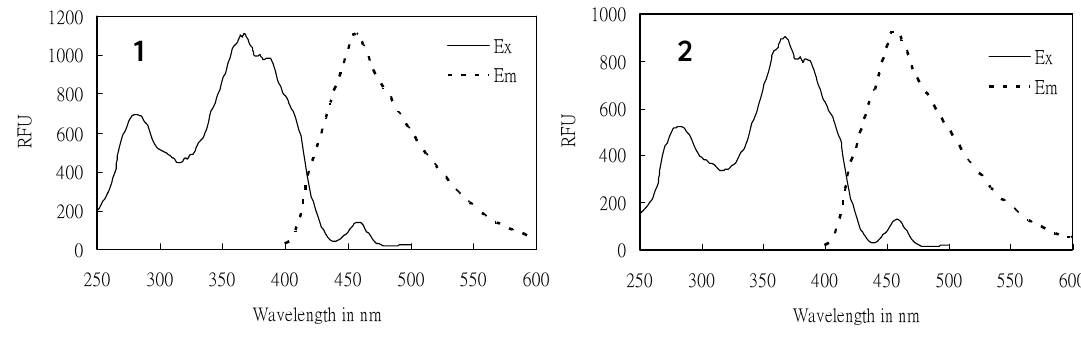
Figure 2. The excitation (Ex) and emission (Em) spectra of (1) monapurfluore A and (2) monapurfluore B, measured by a fluorescence spectrophotometer. ( λ = 456 λ em